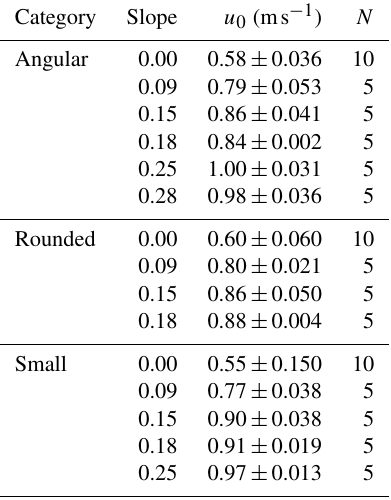
Table 3. Slope-parallel velocities leaving the launcher cradle for rounded, angular, and small particles. Velocities were calculated from high-speed videos of particles launched at varied slopes.